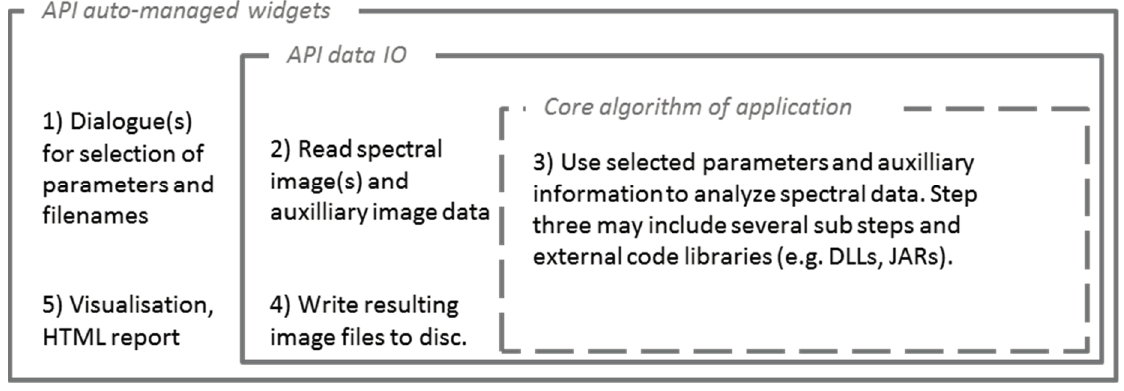
Figure 7. General framework for standardized integration for embedding